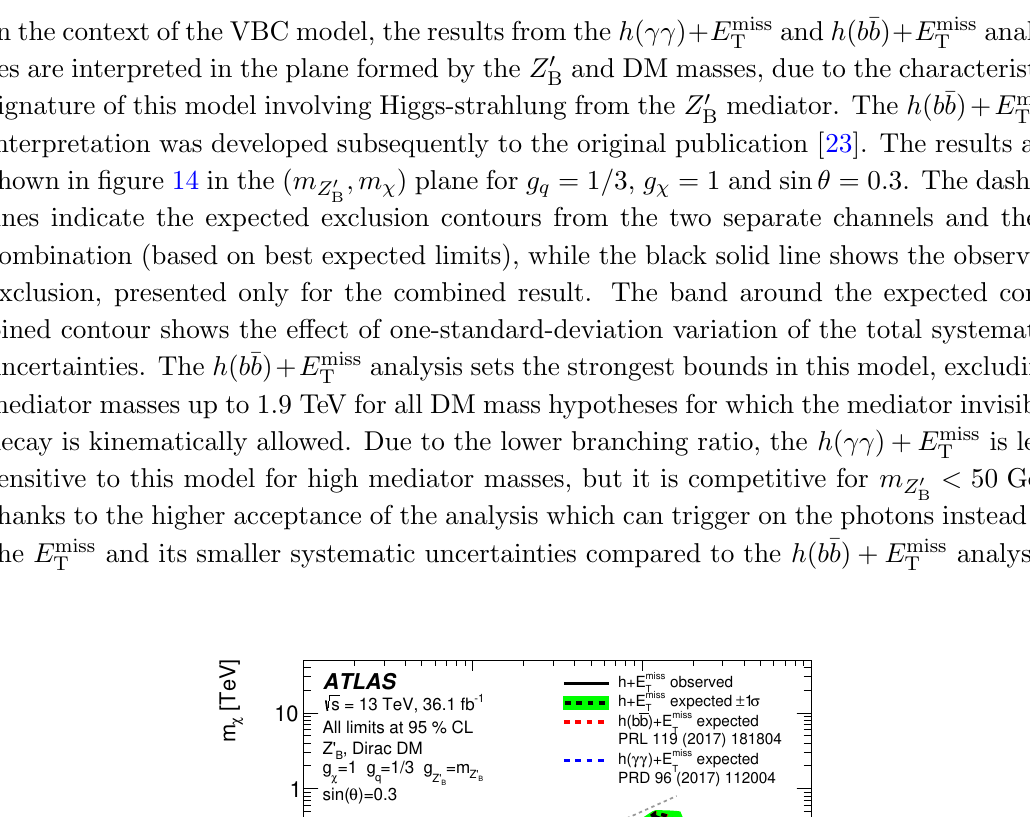
; m (cid:31) ) plane for g q = 1 = 3, g (cid:31) = 1 Z 0 B analysis. T